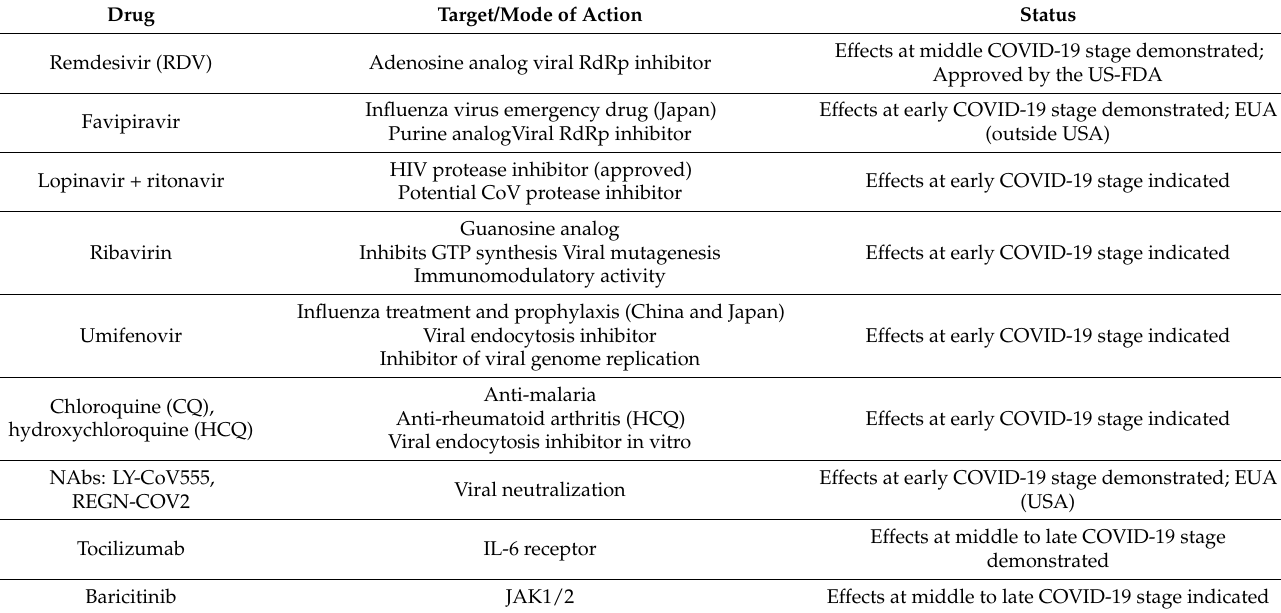
Table 2. Antiviral and therapeutic drugs for treating